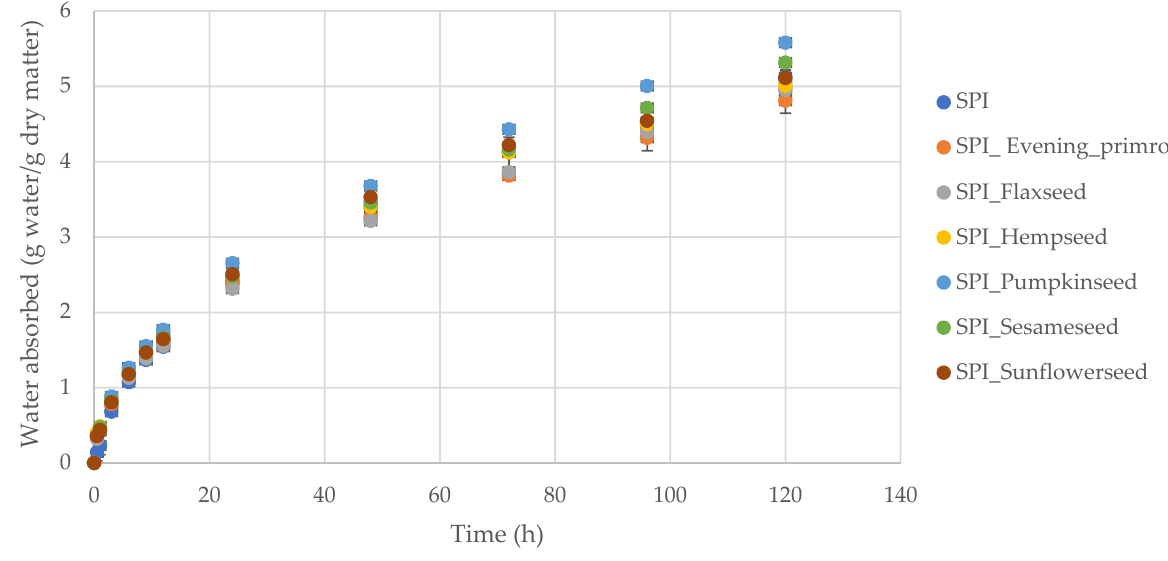
Figure 2. Kinetics of water vapor adsorption by soy protein isolate–oilseed flour films.